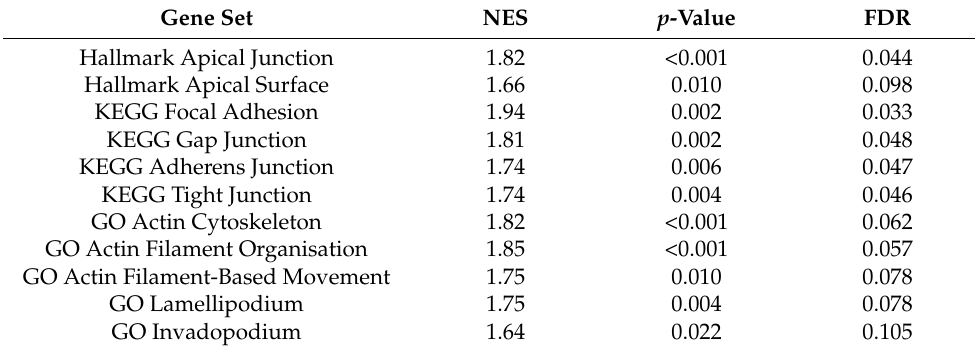
Table 3. Gene sets associated with high SPTAN1 gene expression in the TCGA